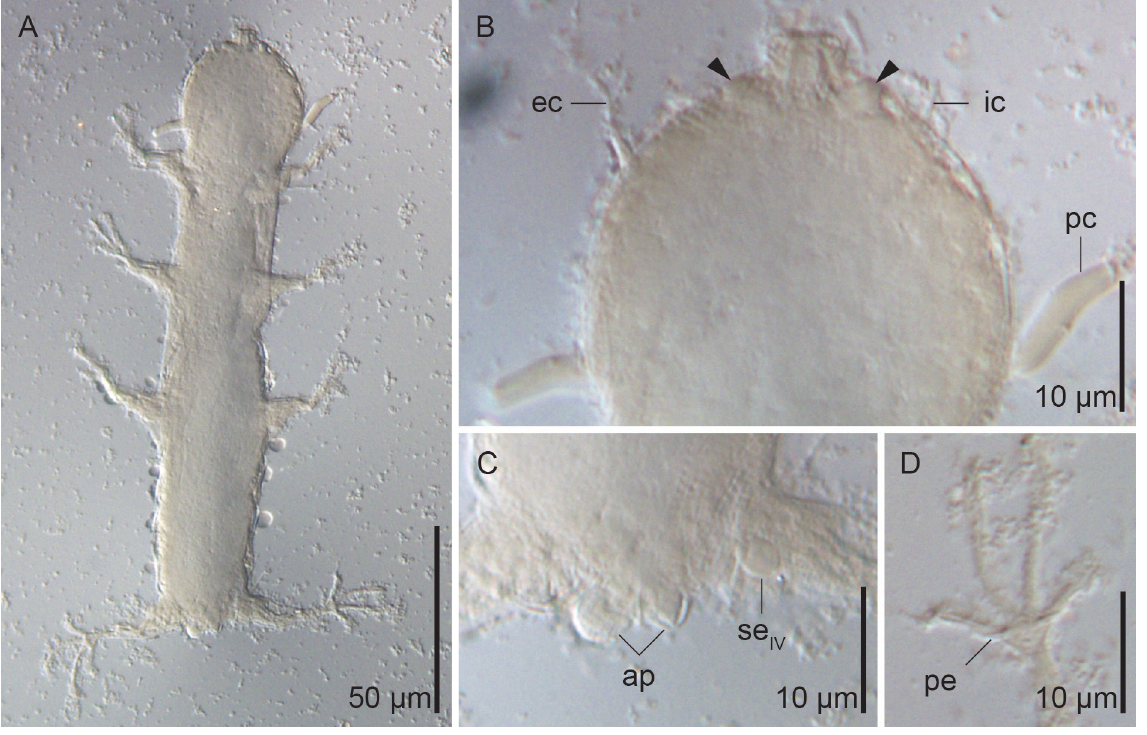
Fig. 1. Micrographs of Angursa bicuspis Pollock, 1979 (USNM W 50900). A . Habitus. B . Cephalic region with paired globular bodies (black arrowheads). C . Caudal region. D . Leg IV